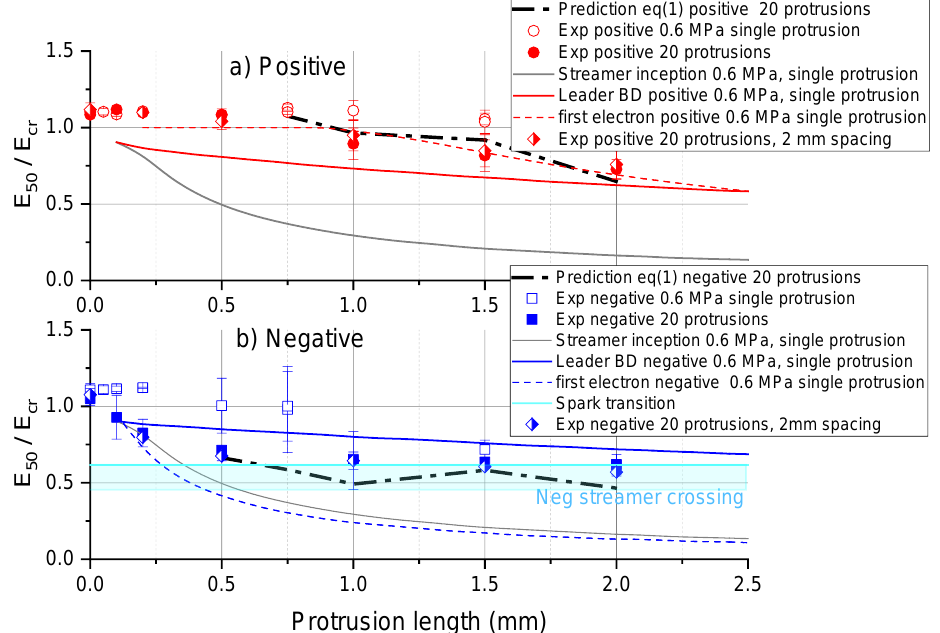
Figure 12. Normalized breakdown fields E 50 / E cr vs. protrusion length L for CO 2 and 20 protrusions at ( a ) positive and ( b ) negative